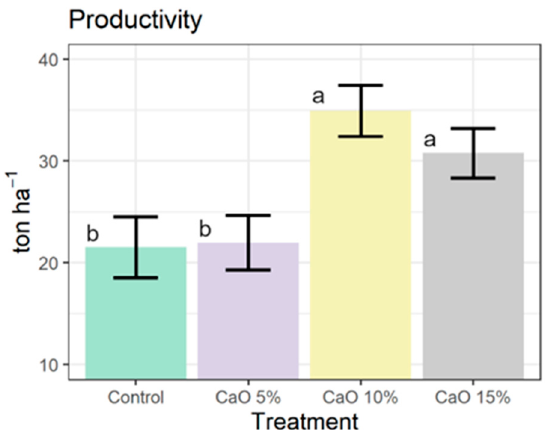
Figure 5. Tuberous root productivity of sweet potato ( Ipomoea batatas L.) plants sprayed with calcium oxide particle films at 5, 10, and 15% w / v and control (water). Values represent mean ( ± standard deviation), and bars followed by the same letter did not differ according to the Tukey test ( p < 0.05).